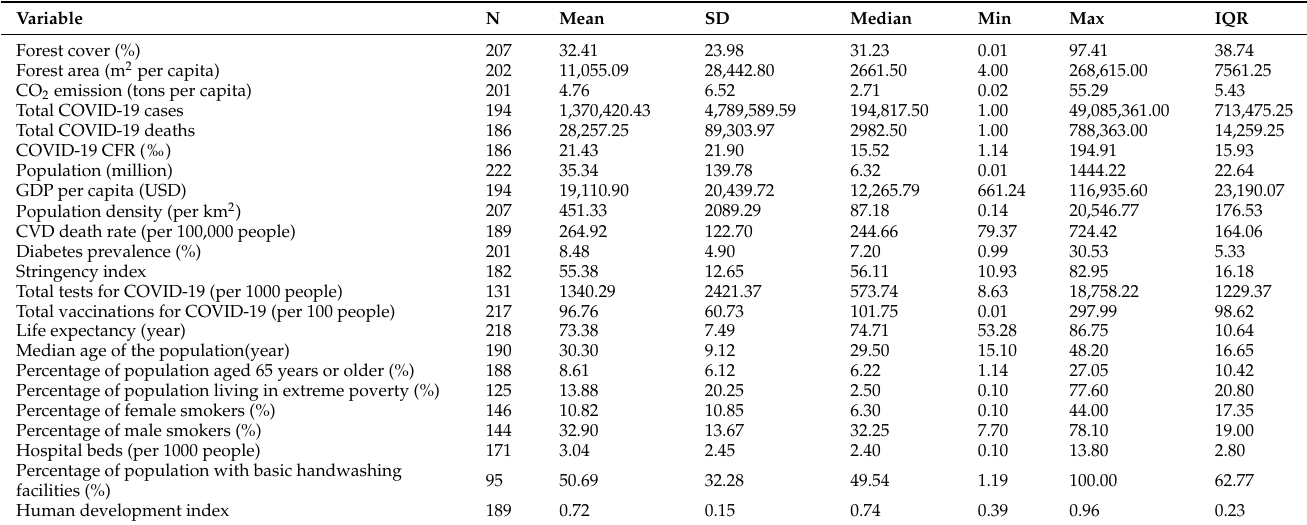
Table 1. Descriptive statistics of the